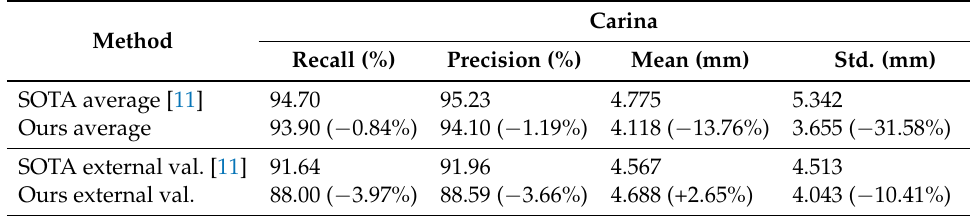
Table 13. The comparison results of recall, precision, and object error on the Carina.